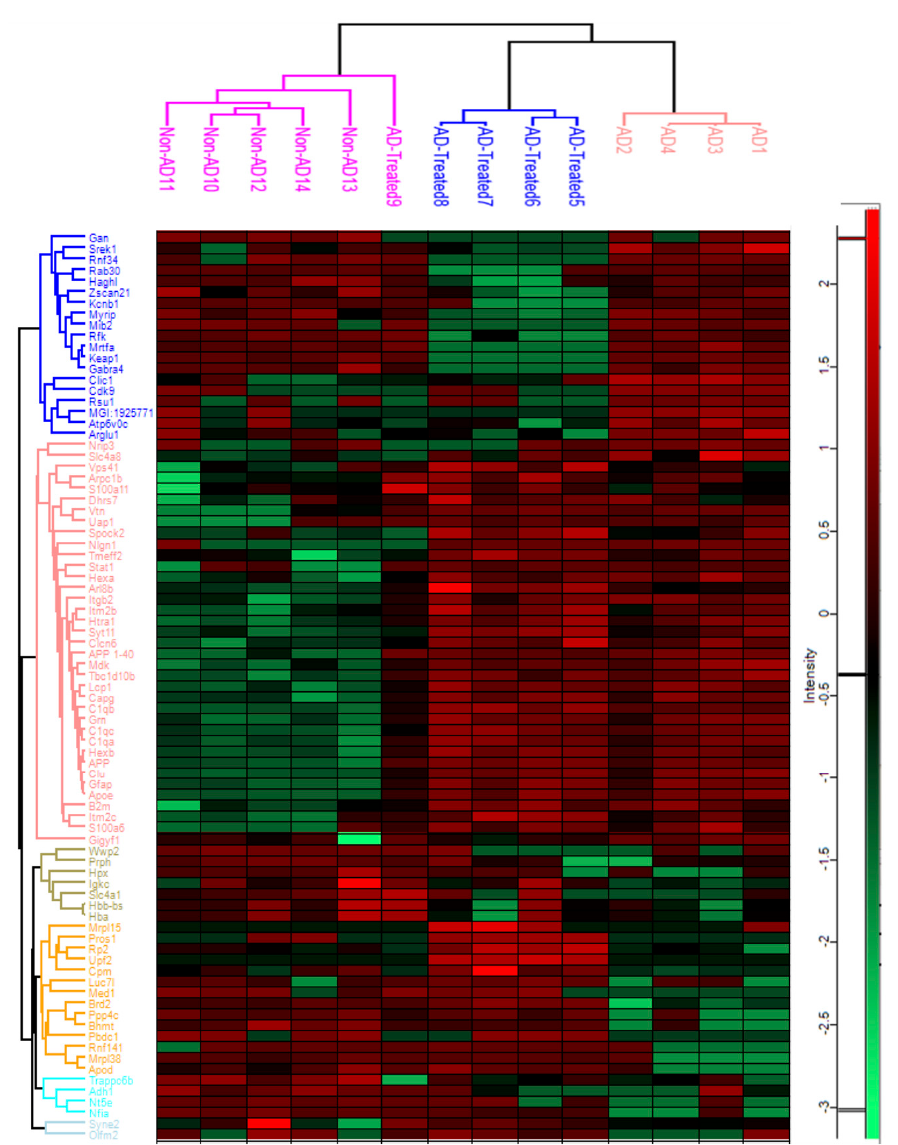
Figure 4. Proteomics analysis of the hippocampus: heatmap analysis of hippocampus homogenates . Analysis showing proteins significantly altered across all group comparisons (non-AD, AD, and treated AD). Red is indicative of upregulation while green is indicative of downregulation.